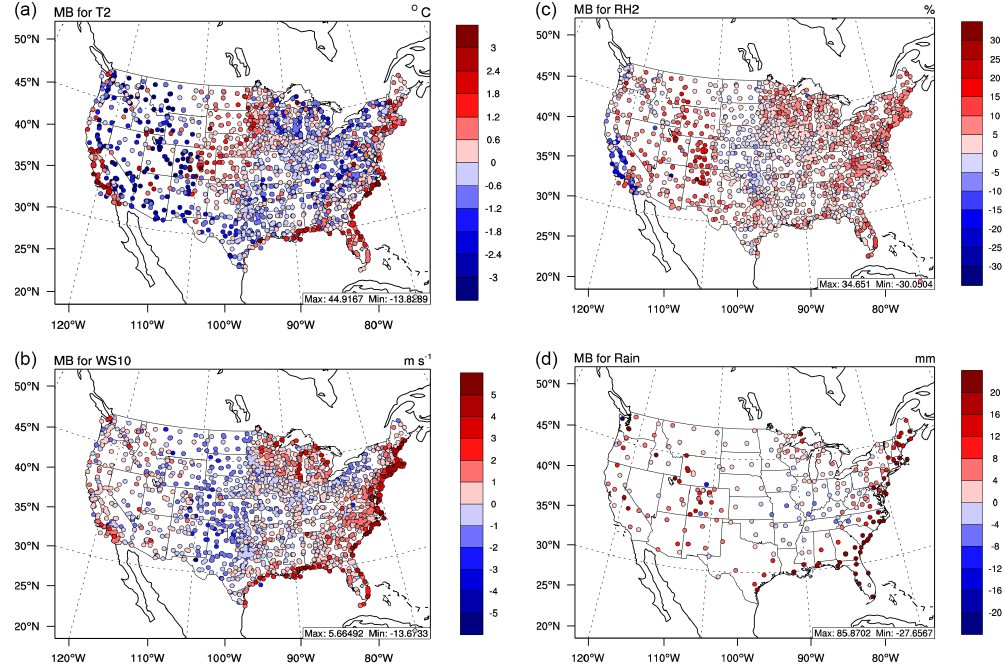
Figure 1. Spatial distribution of MBs for (a) 2m temperature (T2), (b) 2m relative humidity (RH2), (c) 10m wind speed (WS10) from NCDC, and (d) weekly precipitation from NADP. Each marker represents the MB of each variable at each observational site.